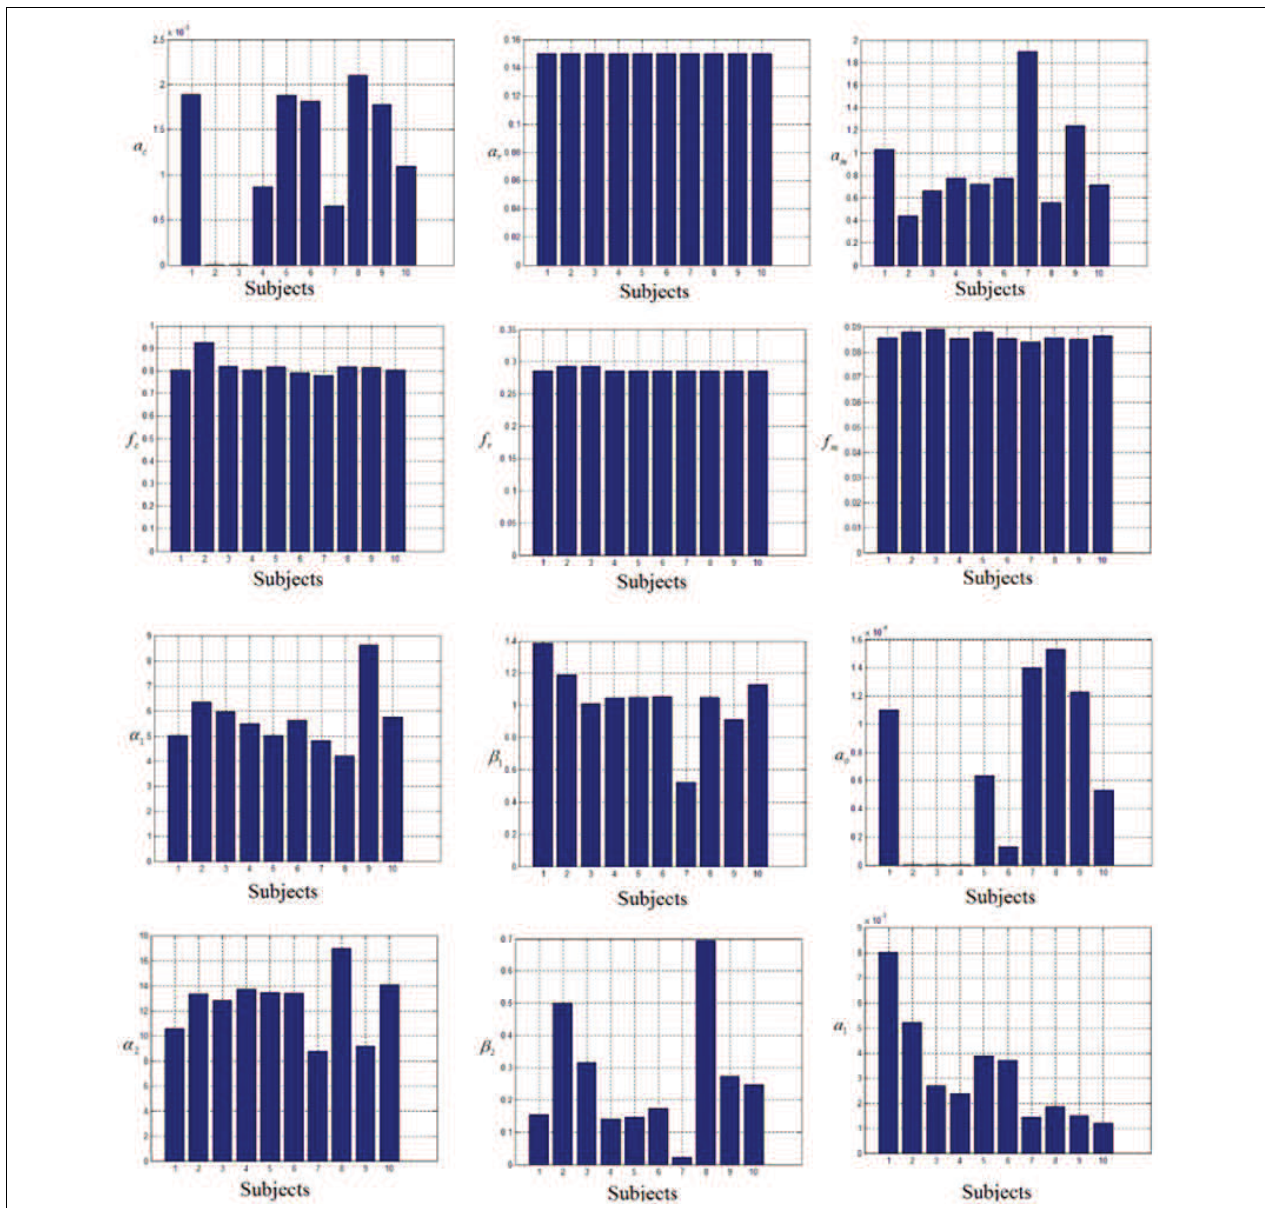
FIGURE 7 | Variations in the estimated parameters in real data sets.